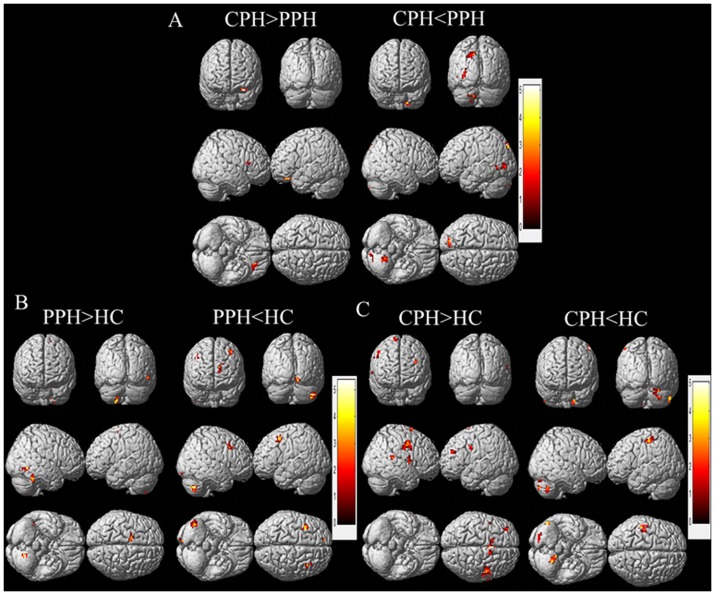
Significant differences in functional connectivity of contralesional M1 between each pair of the three diagnostic groups.A: CPH versus PPH; B: PPH versus HC; C: CPH versus HC. The threshold was set at a combined cutoff value of p<0.01 and a minimum cluster size of 486 mm3 (18 voxels) to yield a corrected threshold of p<0.05 (AlphaSim corrected). Clusters with significant differences were overlapped on render views (posterior-anterior (row 1), right-left (row 2), inferior-superior (row 3)). Color scale = t values.